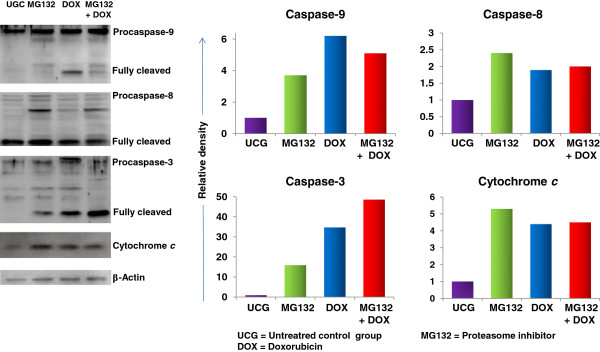
Western blot analysis of caspases −3, -8, and −9 and cytochromecin U937 cells treated with MG132, Doxorubicin (DOX) or MG132 + DOX. U937 cells were cultured and treated with MG132 (1 μM), DOX 1 μM, or with MG132 + DOX. After 24 h, the cells were harvested and lysed. Equivalent amounts of individual lysates were placed onto 10% SDS gradient polyacrylamide gels for electrophoresis and then were electrotransferred onto Immobilon-P PVDF membranes. A representative study is shown. Relative density was calculated using IMAGEJ ver.1.46r software.